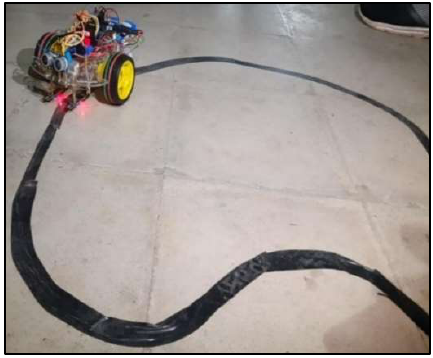
Fig. 2. Line Following Robot Model [2]